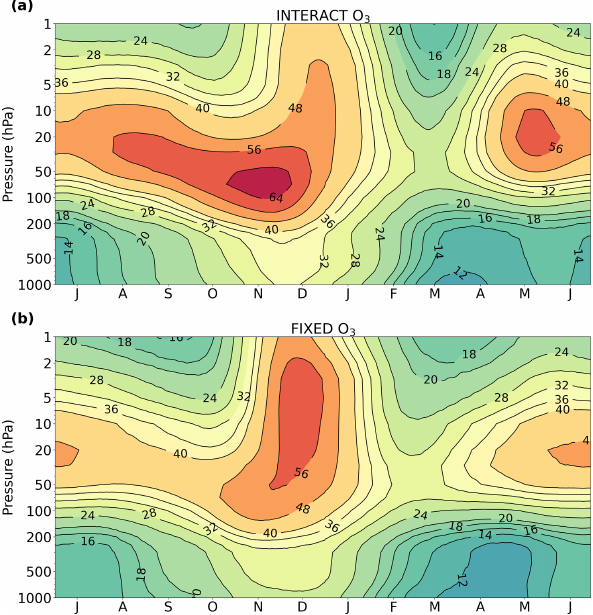
Figure 14. Seasonal cycle of the SAM timescale in INTERACT O 3 (a) and FIXED O 3 (b) . Note that the contour interval is nonlin-